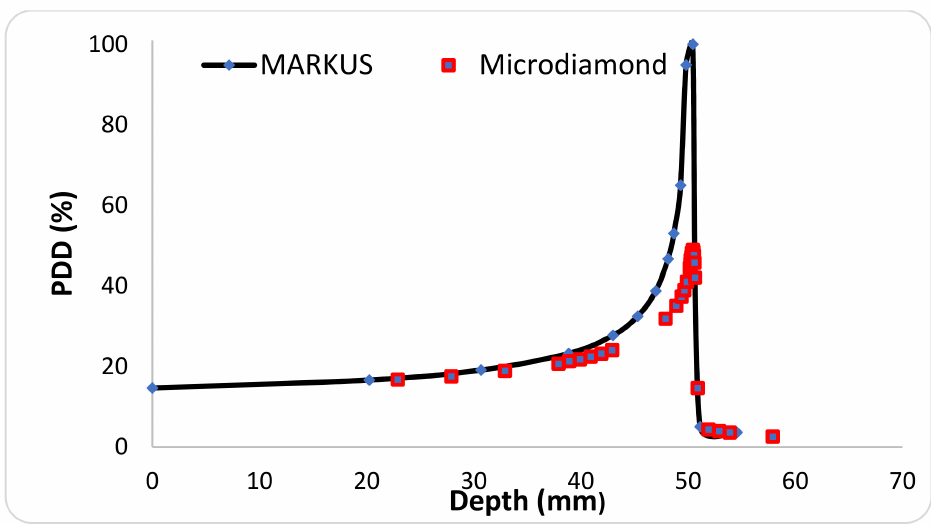
Figure 3. Percentage depth dose curves (PDD) of a 230 MeV/u Ne beam measured with a Markus ionisation chamber (blue points) and with the PTW microdiamond detector (red